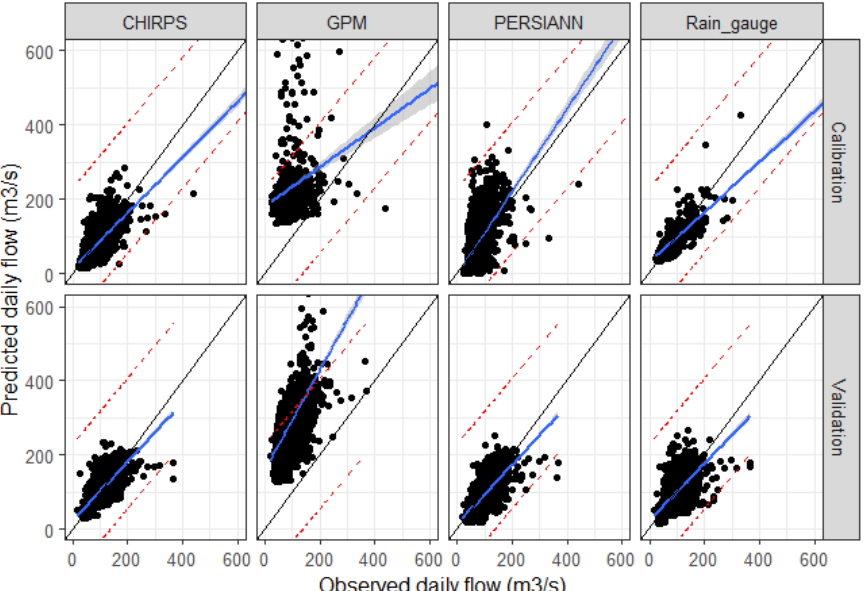
Figure 9. Performance of best simulated daily flow using rain gauge, CHIRPS, GPM, and PERSIANN data plotted with 1:1 line during calibration and validation period. Hydrology 2021 , 8 , x FOR PEER REVIEW